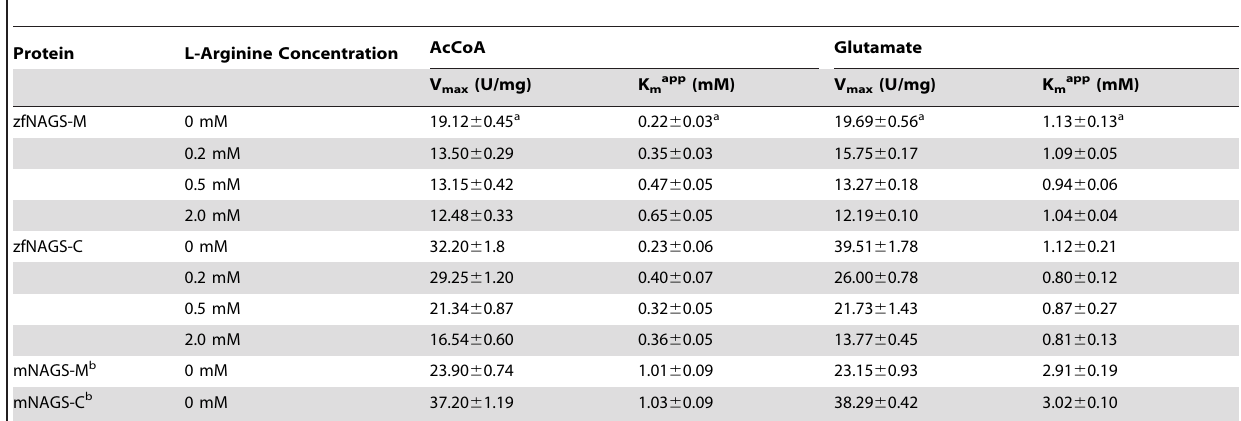
Table 1. Comparison of biochemical properties of purified zebrafish and mouse NAGS proteins.